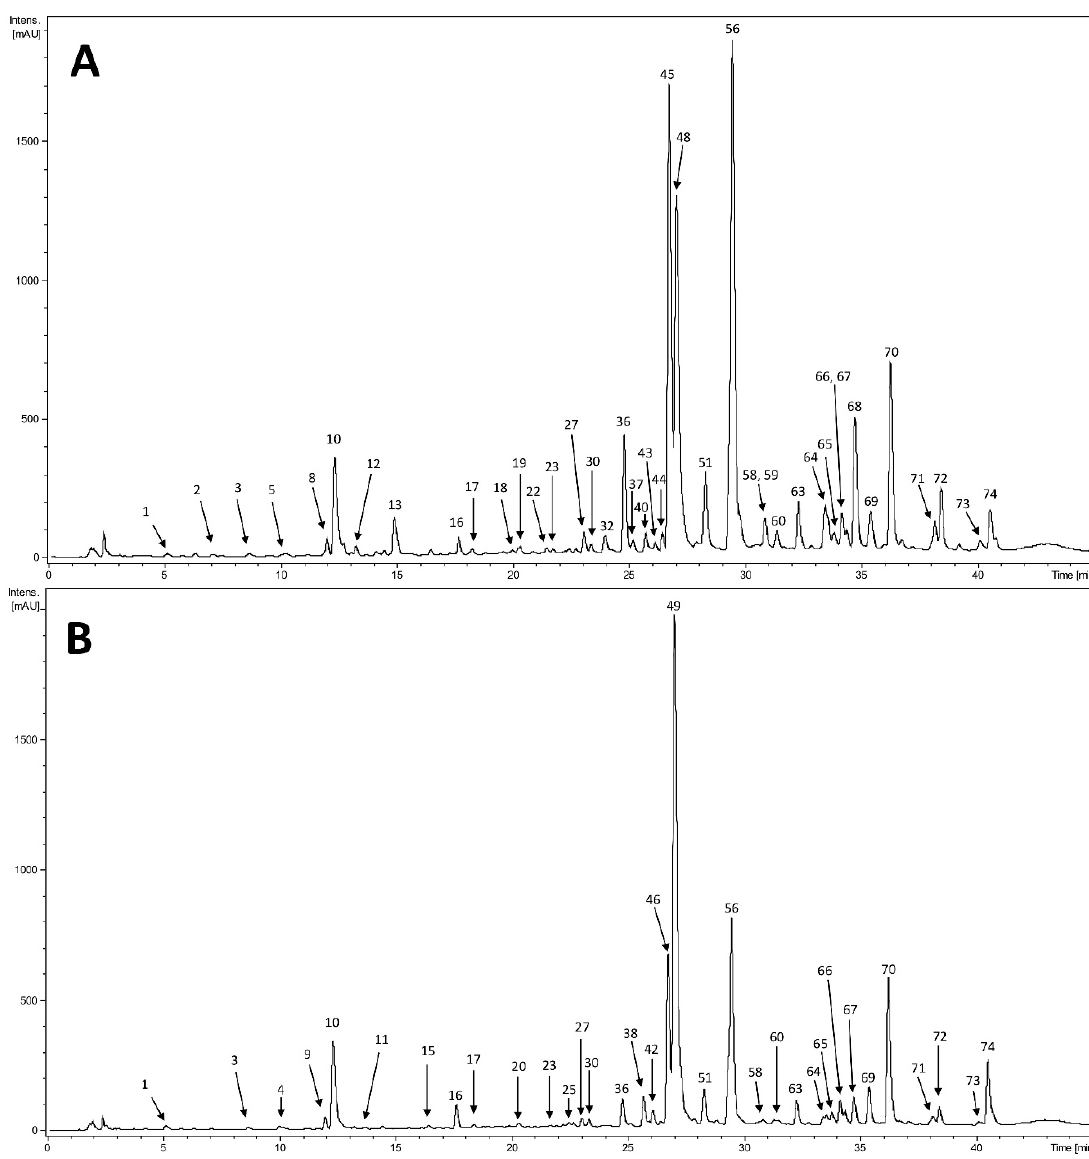
Figure 5. HPLC chromatograms at 254 nm of extracts from roots of: ( A ) Arctium lappa , plant material collected from the natural position of Wola Wy ż na A; ( B ) Arctium tomentosum , plant material collected from the natural position of Strzy ż ów, Zadworze Street.